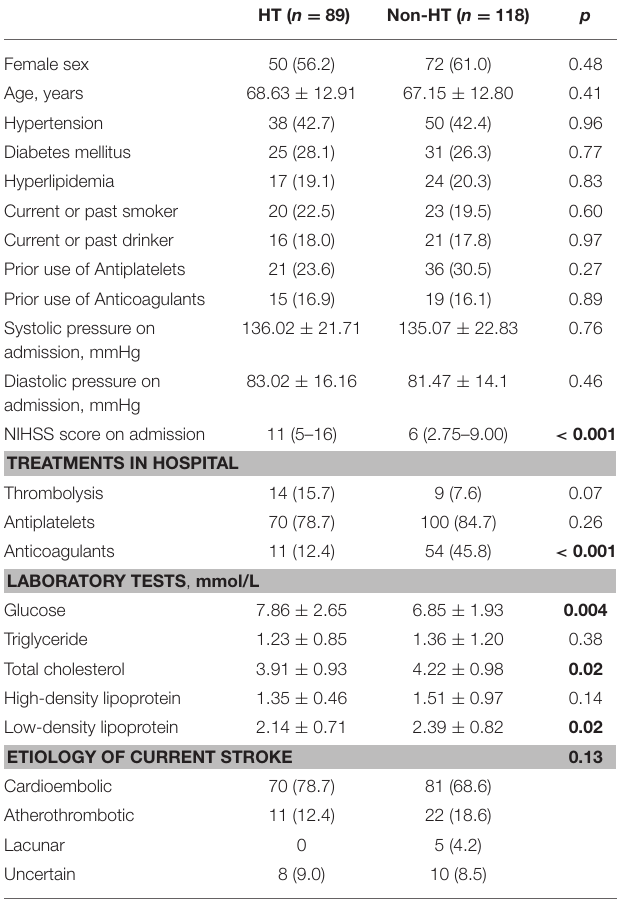
Values are n (%), mean ± SD or median (IQR). Boldface indicates statistical significance. HT, hemorrhagic transformation; SD, standard deviation; IQR, interquartile range; NIHSS, National Institutes of Health Stroke Scale.